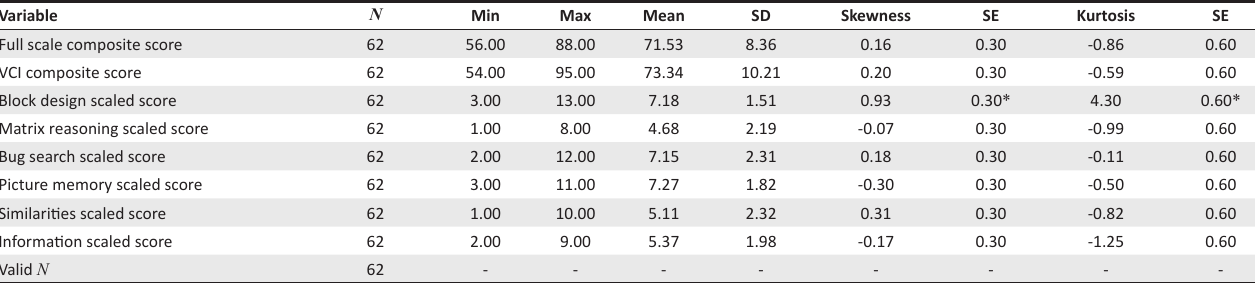
TABLE 6: WPPSI-IV descriptive statistics. Variable